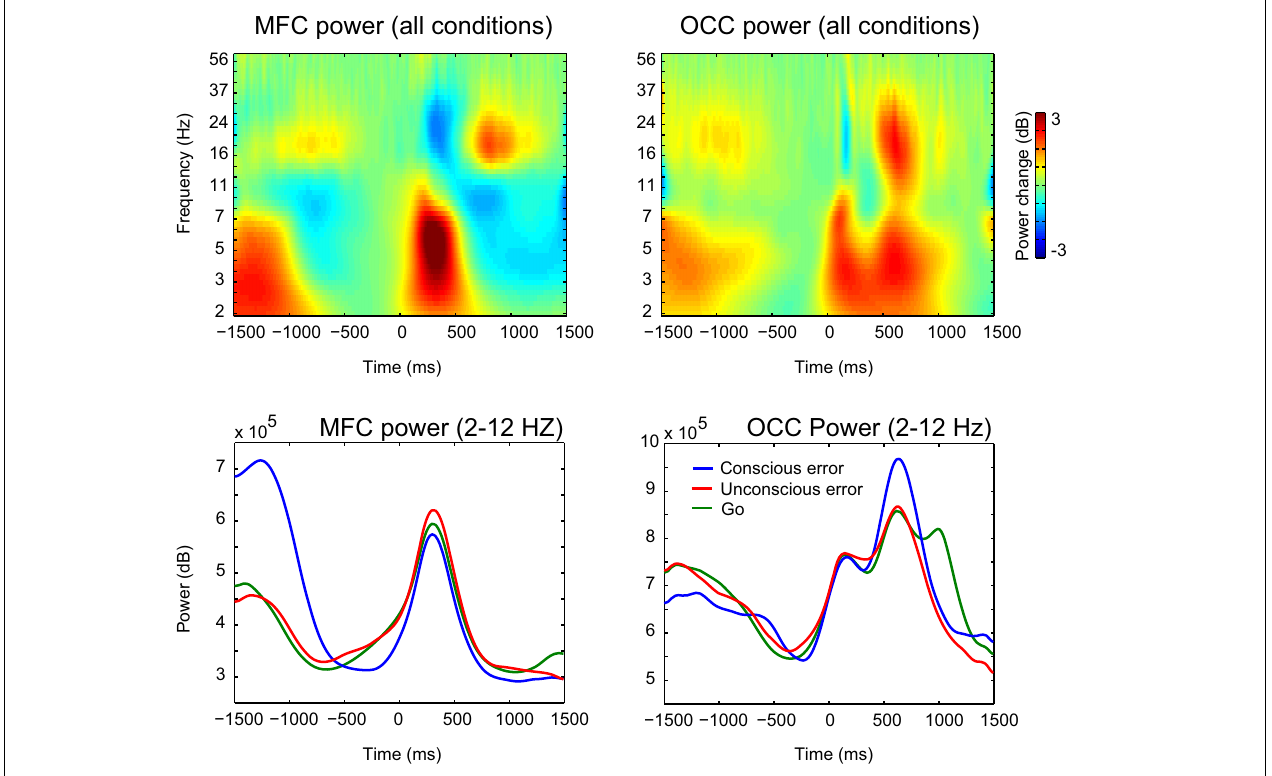
FIGURE 3 | Oscillation power from MFC and OCC. These effects were uncorrelated with changes in oscillation synchrony, suggesting that inter-regional phase synchrony refl ects a mechanism of brain interactions that is independent of the overall amount of localized